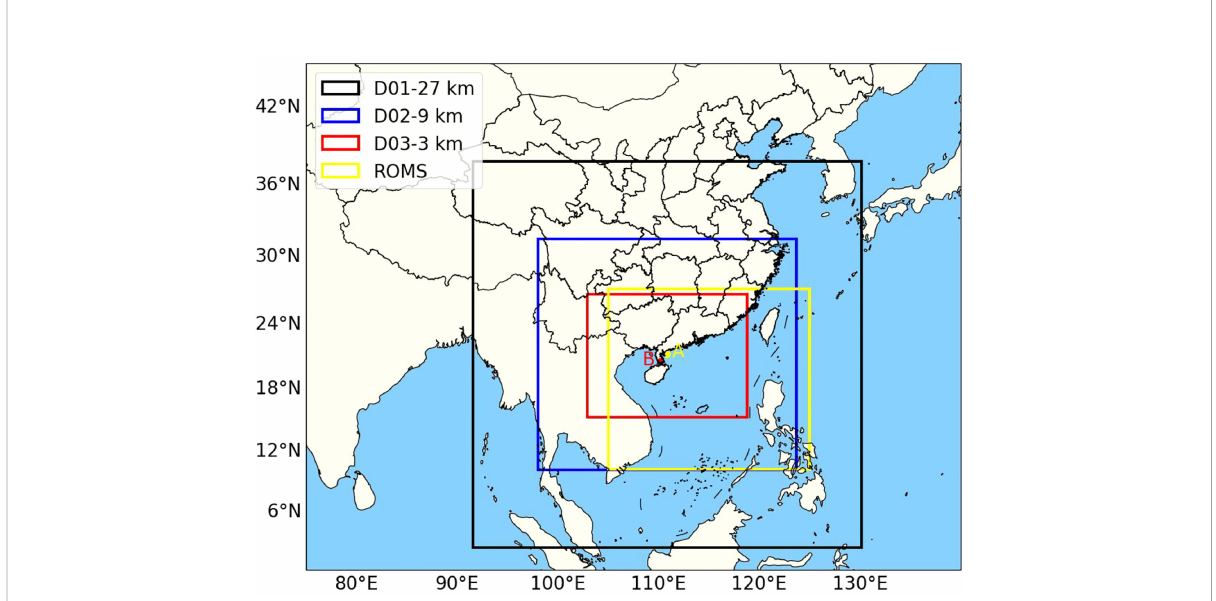
FIGURE 3 Simulation domains of the models (black, blue, and red boxes are the simulation domains of the three-layer atmospheric model, the yellow box is the simulation domain of the oceanic model, and the stations marked by A and B are the offshore and onshore observation stations,